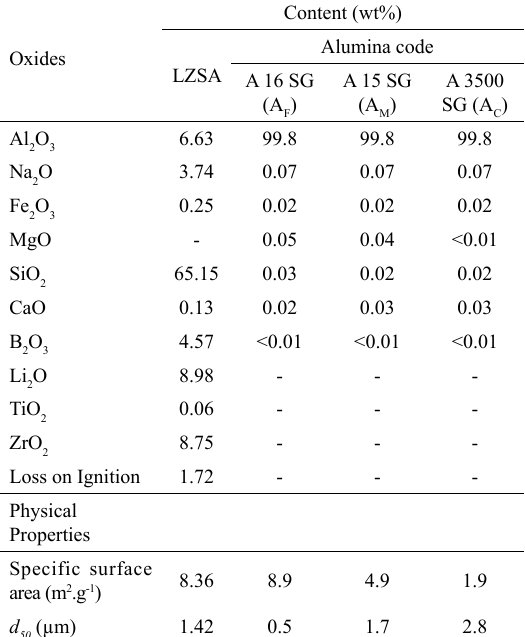
Table 1. Chemical and physical characteristics of the used powders.